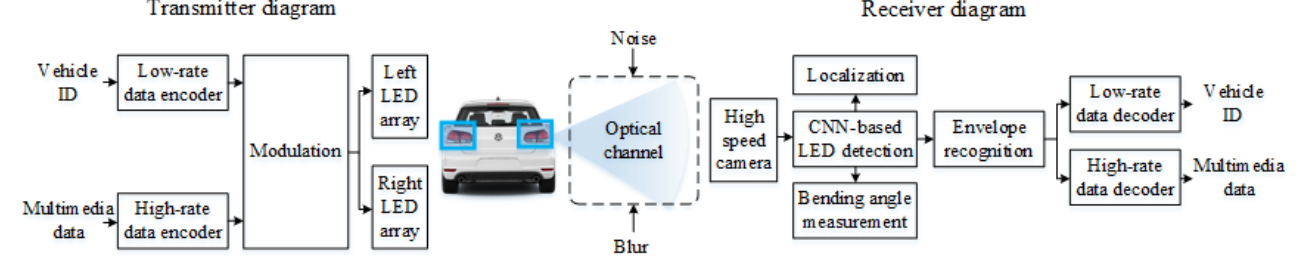
Figure 3. Proposed OCC architecture for vehicle localization and